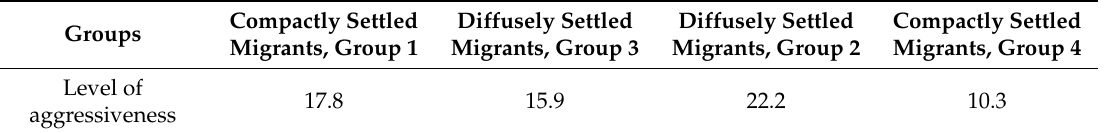
Table 4. The average group level of